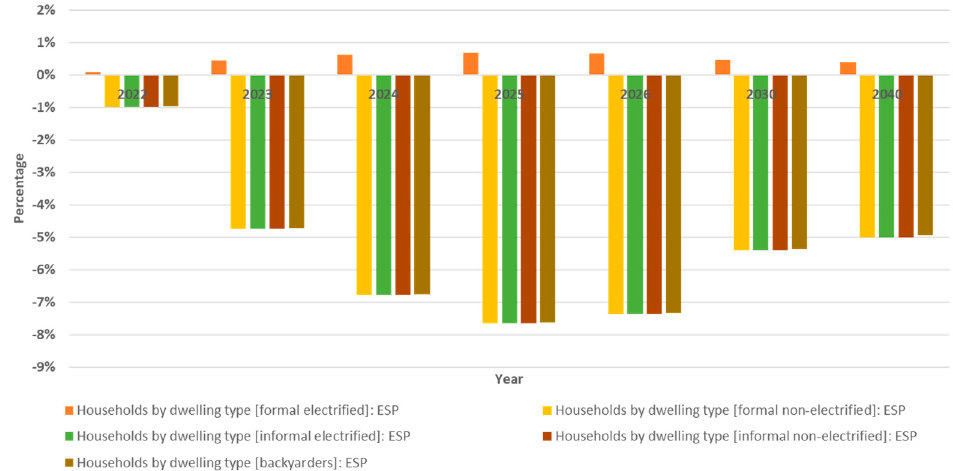
Figure 6. Year-on-year percentage change in households by dwelling type, ESP scenario relative to BAU. Source: Authors.